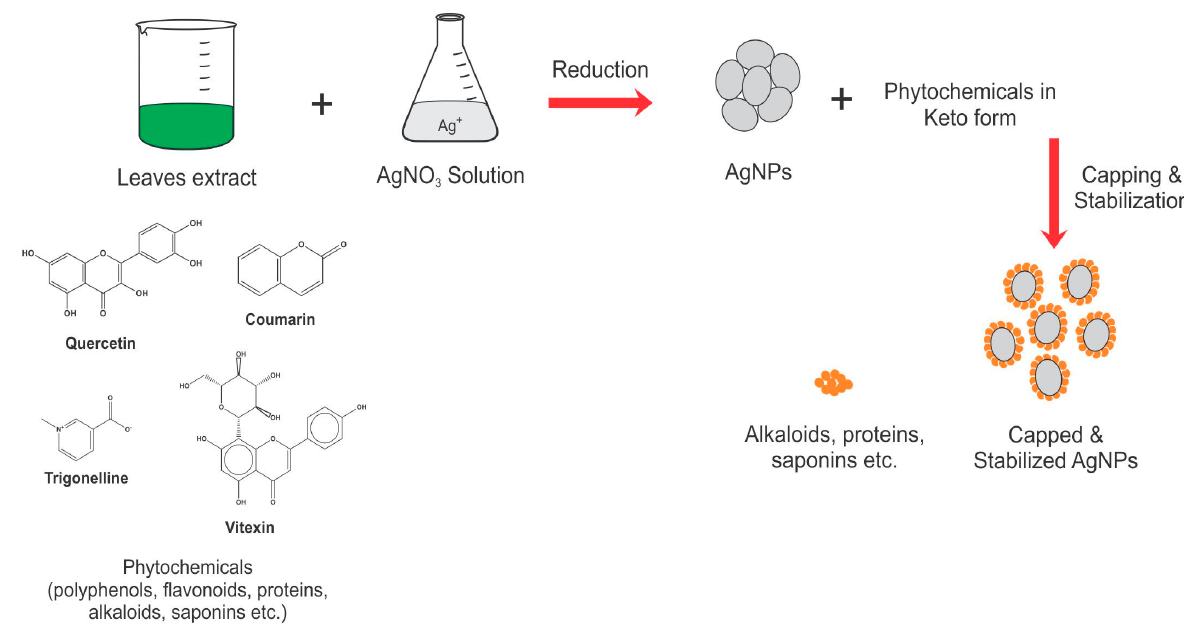
Figure 1. Probable mechanism for the synthesis of AgNPs.